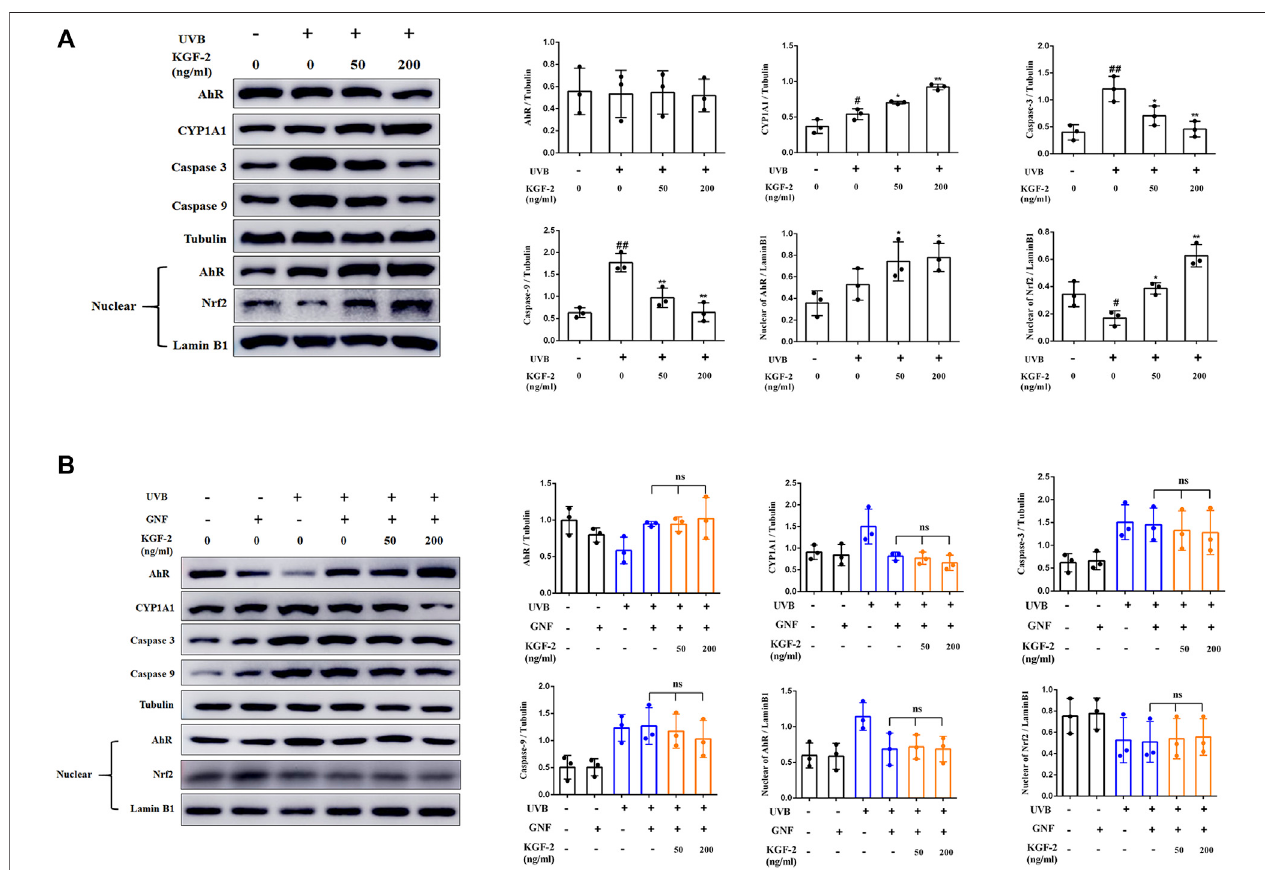
FIGURE4| Effectsof KGF-2on the AhR/Nrf2 signaling pathway in keratinocytes following UVBirradiation. (A) HaCaT cellswere treated with or without KGF-2 for 4 h followed by exposure to UVB (200 mJ/cm 2 ) and a further 30-min incubation. The cells were then subjected to western blot analysis to measure the levels of AhR, CYP1A1, caspase 3, caspase 9 in cytoplasm and the levels of AhR, and Nrf2 in nucleus, the plot compares the protein level of HaCaT cells from three different experiments. AhR: UVB only vs. untreated control group, p (cid:2) 0.9976; KGF-2 (50 ng/ml) vs. UVB only group, p (cid:2) 0.9995; KGF-2 (200 ng/ml) vs. UVB only group, p (cid:2) 0.9995. CYP1A1: UVB only vs. untreated control group, p (cid:2) 0.0288; KGF-2 (50 ng/ml) vs. UVB only group, p (cid:2) 0.0378; KGF-2 (200 ng/ml) vs. UVB only group, p (cid:2) 0.0003.Caspase3:UVBonly vs. untreatedcontrolgroup, p (cid:2) 0.0015;KGF-2(50 ng/ml) vs. UVBonlygroup, p (cid:2) 0.0237;KGF-2(200 ng/ml) vs. UVBonly group, p (cid:2) 0.0025.Caspase9:UVBonly vs. untreatedcontrolgroup, p (cid:2) 0.0003;KGF-2(50 ng/ml) vs. UVBonlygroup, p (cid:2) 0.0025;KGF-2(200 ng/ml) vs. UVBonly group, p (cid:2) 0.0003.AhRinnucleus: UVBonly vs. untreated controlgroup, p (cid:2) 0.3802;KGF-2(50 ng/ml) vs. UVBonlygroup, p (cid:2) 0.2422;KGF-2(200 ng/ml) vs. UVB only group, p (cid:2) 0.1558. Nrf2 in nucleus: UVB only vs. untreated control group, p (cid:2) 0.0390; KGF-2 (50 ng/ml) vs. UVB only group, p (cid:2) 0.0131; KGF-2 (200 ng/ml) vs. UVB only group, p (cid:2) 0.0001. (B) HaCaT cells were pretreated with or without GNF351 for 12 h followed by identical treatment as western blot analysis as in A. AhR: KGF-2 (50 ng/ml) vs. UVB + GNF group, p (cid:2) 0.9999; KGF-2 (200 ng/ml) vs. UVB + GNF group, p (cid:2) 0.9746. CYP1A1: KGF-2 (50 ng/ml) vs. UVB + GNF group, p (cid:2) 0.9987; KGF-2 (200 ng/ml) vs. UVB + GNF group, p (cid:2) 0.9746. Caspase 3: KGF-2 (50 ng/ml) vs. UVB + GNF group, p (cid:2) 0.9898; KGF-2 (200 ng/ml) vs. UVB + GNF group, p (cid:2) 0.9650. Caspase 9: KGF-2 (50 ng/ml) vs. UVB + GNF group, p (cid:2) 0.9904; KGF-2 (200 ng/ml) vs. UVB + GNF group, p (cid:2) 0.7419. AhR in nucleus: KGF-2(50 ng/ml) vs. UVB+GNFgroup, p (cid:2) 0.9997;KGF-2(200 ng/ml) vs. UVB+GNFgroup, p (cid:2) 0.9999. Nrf2in nucleus:KGF-2(50 ng/ml) vs. UVB+GNFgroup, p (cid:2) 0.9997; KGF-2 (200 ng/ml) vs. UVB + GNF group, p (cid:2) 0.9971. All graphical data are the means ± SD from three independent experiments, “ # ” and “ ## ” indicate signi fi cantly different from the untreated control group at the p < 0.05 and p < 0.01 levels, respectively, “ * ” and “ ** ” indicate signi fi cantly different from the UVB